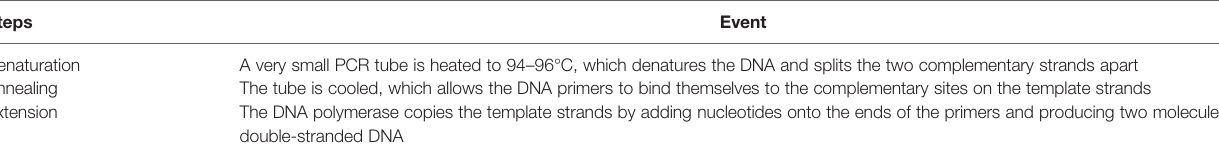
TABLE 7 | Summary of the steps and events in